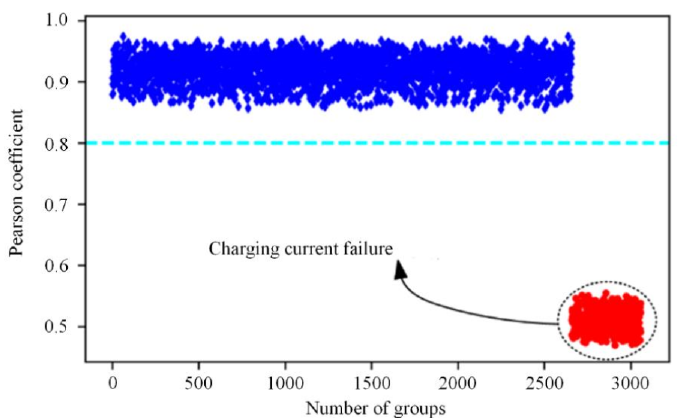
Figure 7. Change of Pearson coefficient of ADBN 1 predicted output and measured value.